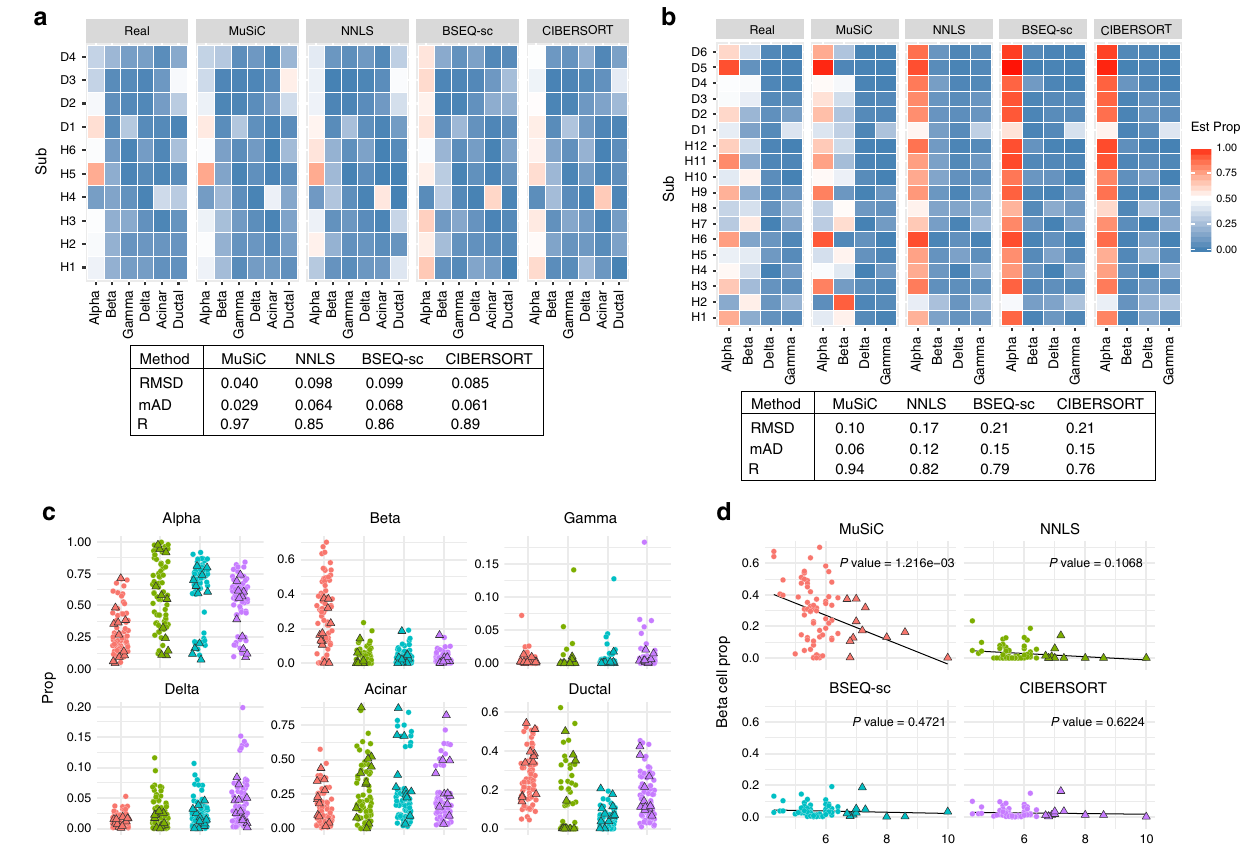
Fig. 2 Pancreatic islet cell type composition in healthy and T2D human samples. a , b Benchmarking of deconvolution accuracy on bulk data constructed by combining together scRNA-seq samples. a The bulk data is constructed for 10 subjects from Segerstolpe et al. while the single-cell reference is taken from the same dataset. The cell type proportions of healthy subjects are estimated by leave-one-out single cell reference. The subject names are relabeled; the table shows average root mean square error (RMSD), mean absolute deviation (mAD), and Pearson correlation (R) across all samples and cell types. b The bulk data is constructed for 18 subjects from Xin et al. while the single cell reference is six healthy subjects from Segerstolpe et al. c Jitter plots of estimated cell type proportions for Fadista et al. subjects, color-coded by deconvolution method. Of the 89 subjects from Fadista et al., only the 77 that have recorded HbA1c level are plotted, and T2D subjects are denoted as triangles while non-diabetic subjects are denoted as dots. d HbA1c vs beta cell type proportions estimated by each of 4 methods. The reported p -values are from single variable regression β cell proportion ~HbA1c. Multivariable regression results are reported in Supplementary Table 1. Supplementary Figure 7 shows the deconvolution results of Fadista et al. with the inDrop data from Baron et al. as single-cell reference. The corresponding multivariable regression results are shown in Supplementary Table 2. Source data are provided as a Source Data